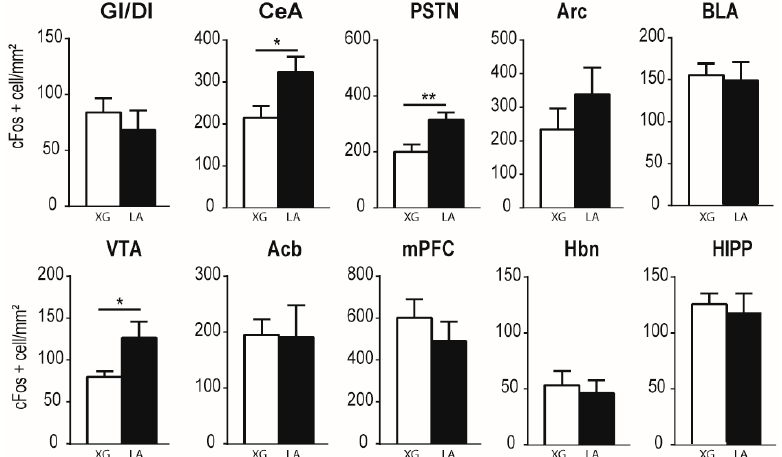
Figure 2. Linoleic acid deposition on the tongue activates c-Fos expression in the major cerebral structures related to emotional and reward traits. Bar graph representation of the density of c-Fos immunopositive cells (number of c-Fos positive cells/mm 2 ) in mice subjected to oral stimulation with linoleic acid (LA) or xanthan gum as control solution. Values are means ± SEM; n = 6; for each structure studied, treatment effects on c-Fos expression were assessed using unpaired one-sided t -tests. * p < 0.05; ** p < 0.01. Acb, accumbens nucleus; Arc, arcuate nucleus; BLA, basolateral amygdaloid nucleus; CeA, central amygdaloid nucleus; GI/DI, granular/dysgranular insular cortex; Hbn, habenula; Hipp, hippocampus; mPFC, medial prefrontal cortex; PSTN/CbN, parasubthalamic nucleus/calbindin nucleus; VTA, ventral tegmental area.